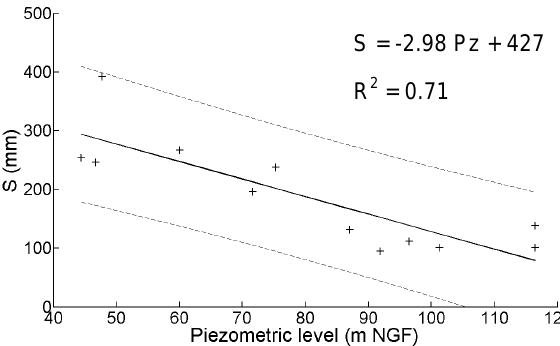
Figure 8: linear regression between initial condition S and the piezometric level at « Claret » 2 Fig. 8. Linear regression between initial condition S and piezomet- (piezometer 9). The dashed lines represent the 95% confidence limits. 3 ric level at “Claret ” (piezometer 9). The dashed lines represent the 95% confidence